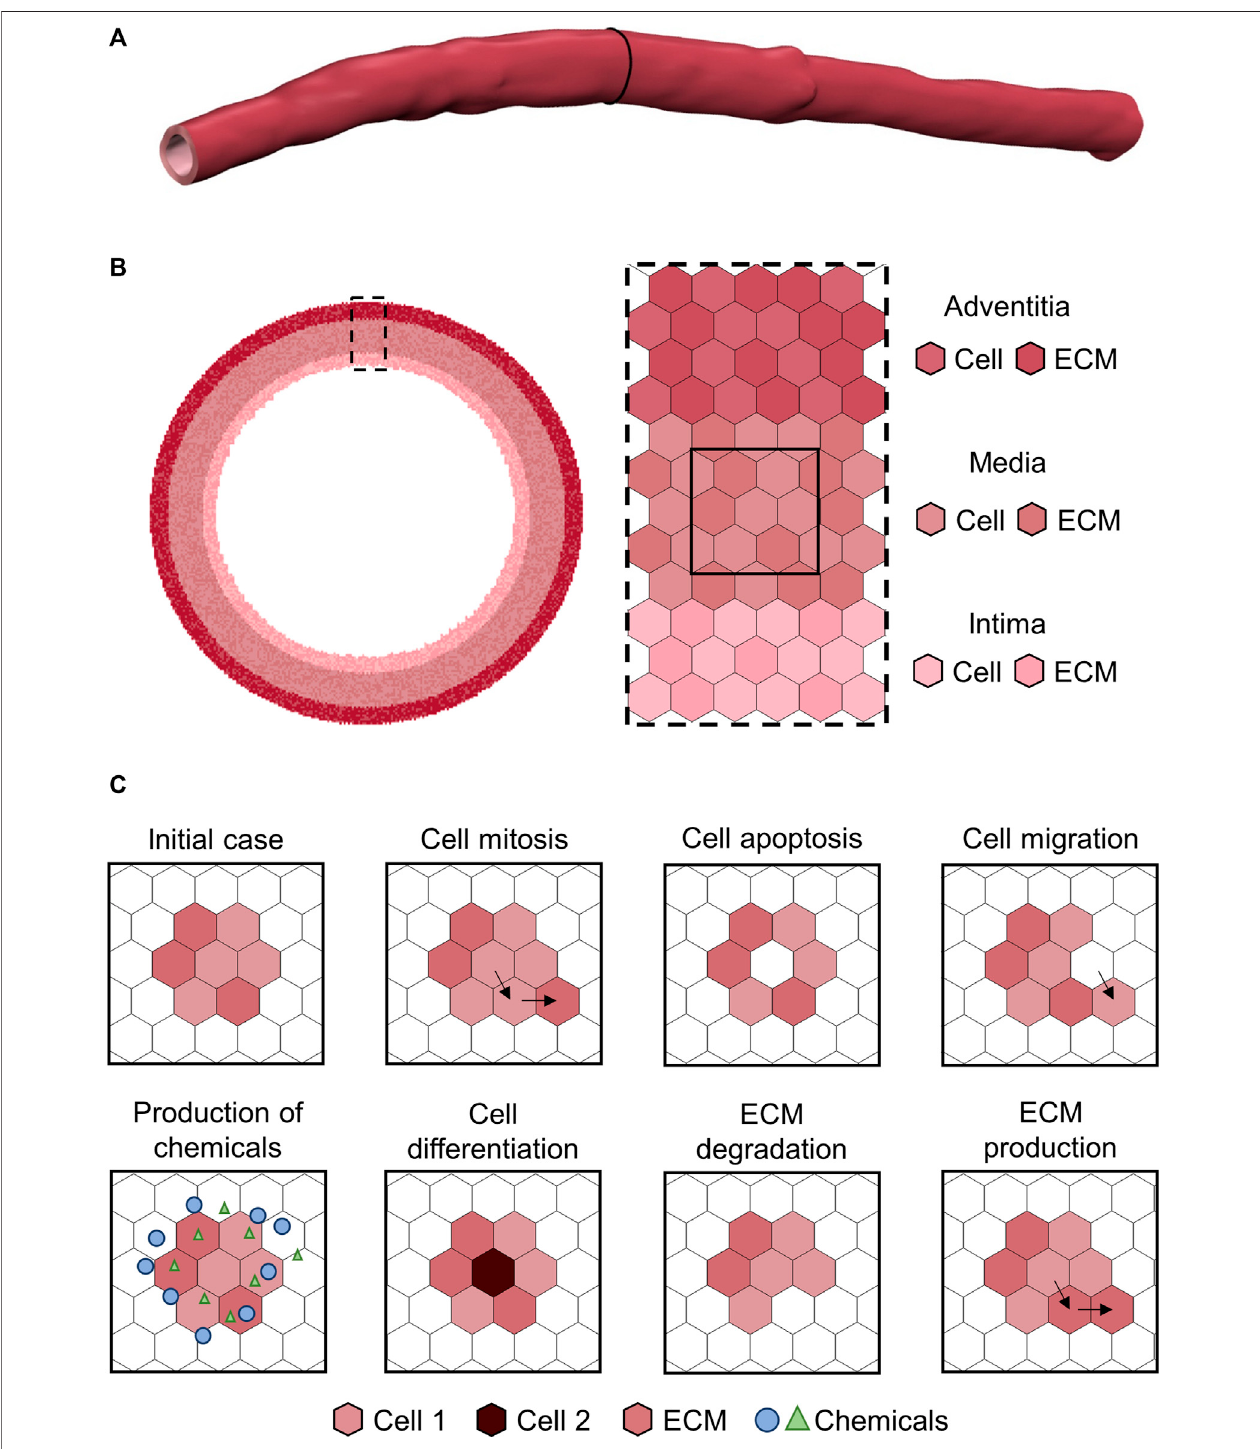
FIGURE 2 | Example of agent-based model (ABM) of vascular wall at the cell-tissue scale implemented on a hexagonal lattice, as in Corti et al. (2020). (A) Three- dimensional patient-speci fi c vessel geometry. (B) Cell-tissue scale ABM of a vessel cross-section implemented on a hexagonal lattice. The vessel wall is composed by the intima, media and adventitia layers. Each layeris populated bycell and extracellularmatrix(ECM) agents, witheach agent occupyingone lattice site. (C) Examples of ABM rules.